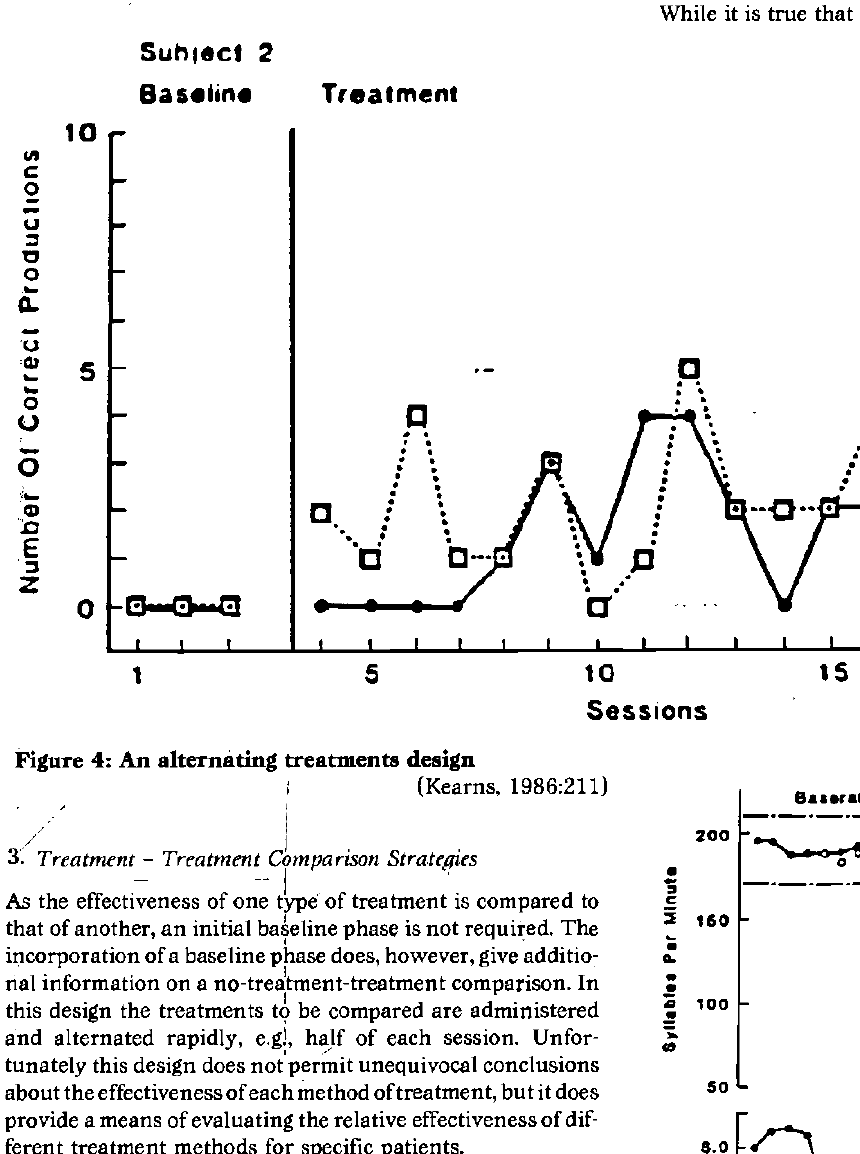
Figure 4: An alternating treatments design